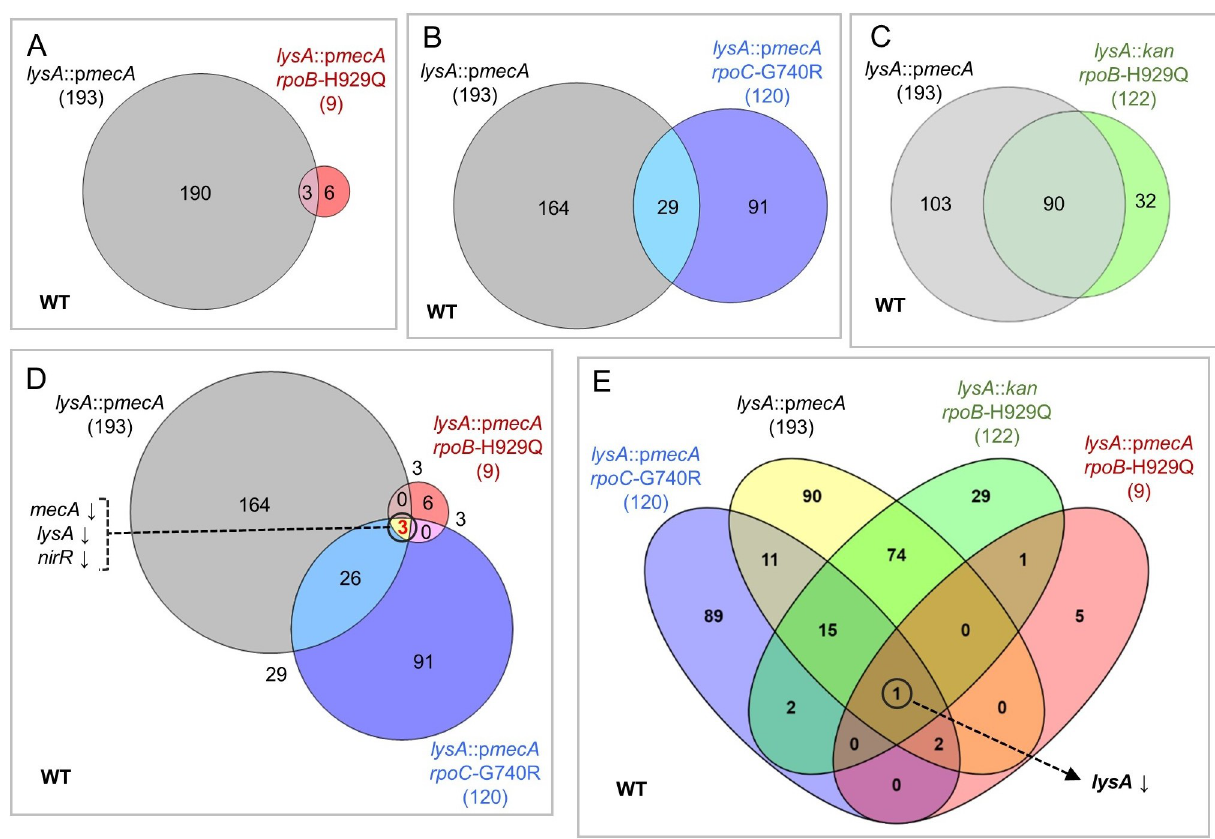
Fig 5. Differential gene expression in SH1000 follows the acquisition of chromosomal mecA and the rpoB/C mutations. Two-set proportional Venn diagram illustrating the total number of differentially expressed genes (DEGs) altered in A) lysA ::p mecA (SJF4996) (grey) and lysA ::p mecA rpoB -H929Q (SJF5003) (red), B) lysA ::p mecA (SJF4996) (grey) and lysA ::p mecA rpoC -G740R (SJF5034) (blue) and C) lysA ::p mecA (SJF4996) (grey) and lysA :: kan rpoB - H929Q (SJF5010) (green) compared to WT (white background). D) Three-set proportional Venn diagram displaying the shared DEGs among lysA :: p mecA (SJF4996) (grey), lysA ::p mecA rpoB -H929Q (SJF5003) (red) and lysA ::p mecA rpoC -G740R (SJF5034) (blue) compared to WT (white background). 3 common DEGs ( mecA , lysA , nirR ) are marked by a circle showing reduced expression. E) The lysA gene (marked by a circle) was shared among four strains based on comparisons from c) and d) compared to WT (white background). The expression of lysA was reduced in all four strains compared WT, marked by a downward arrow.